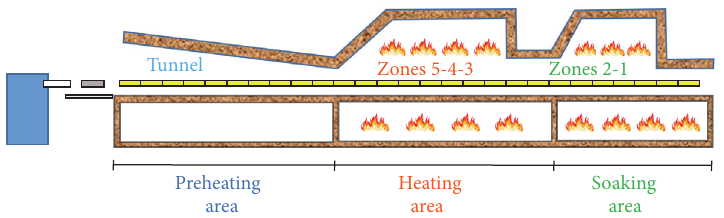
Figure 2: Representation of the considered walking beam billets reheating furnace.